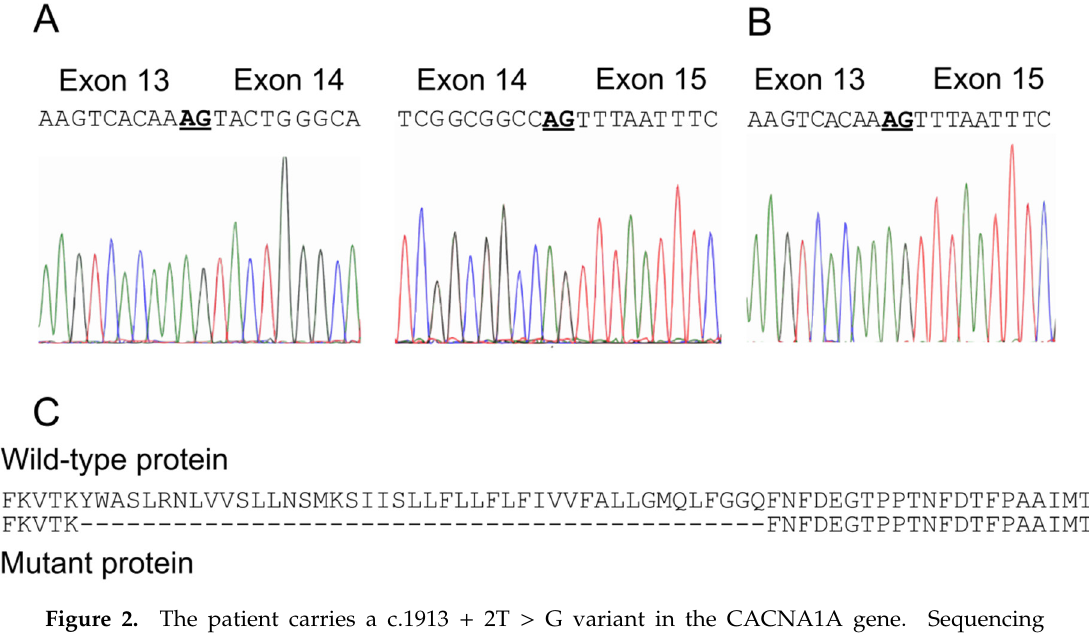
Figure 2. The patient carries a c.1913 + 2T > G variant in the CACNA1A gene. Sequencing chromatograms of a partial cDNA sequence of a healthy subject and the affected patient showing ( A ) exon 13/14 and exon 14/15, and ( B ) the abnormal junction ( AG ) between the exon 13 and 15 of the patient. ( C ) Alignment of the wild-type (top) and mutant (bottom) Cav2.1 protein showing the amino acid sequence that is predicted to be deleted (dashed line) as a consequence of the in-frame mutation.